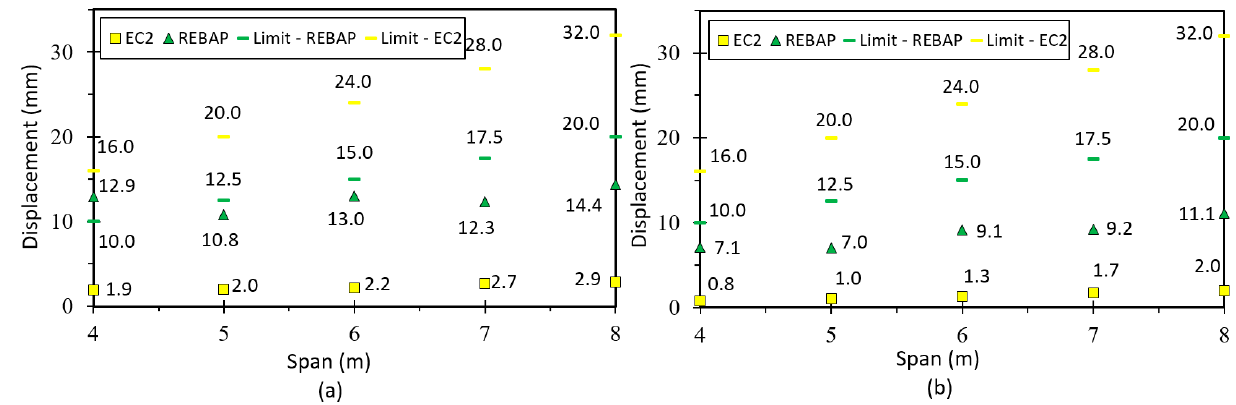
Figure 21. Deformation values of 2NLM: ( a ) analytical and ( b ) numerical, with their limit values, for fixed-ended supported slab.